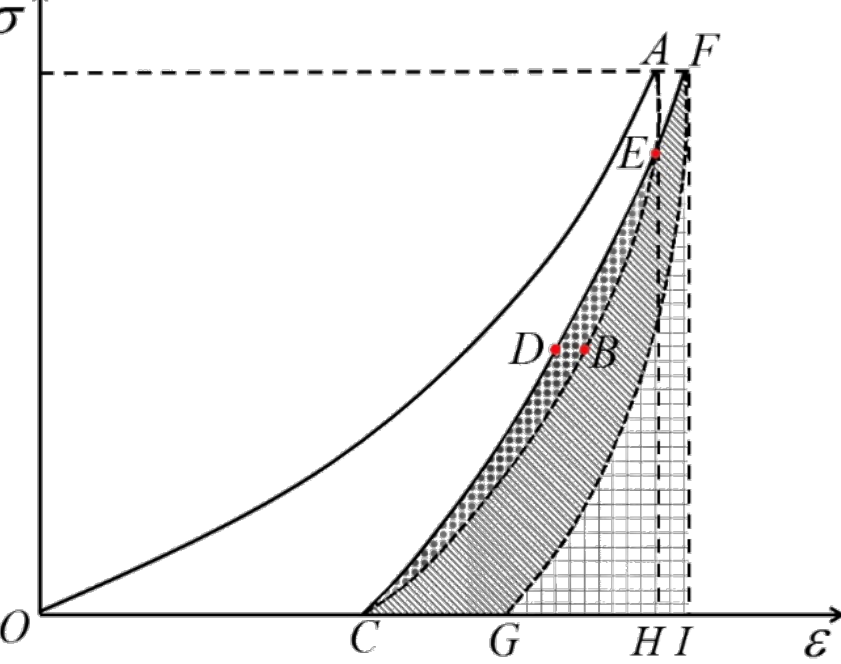
Figure 4. The elastic and plastic strain energy calculation under loading/unloading. The red dots indicate the critical points of dissipated energy required to create new cracks